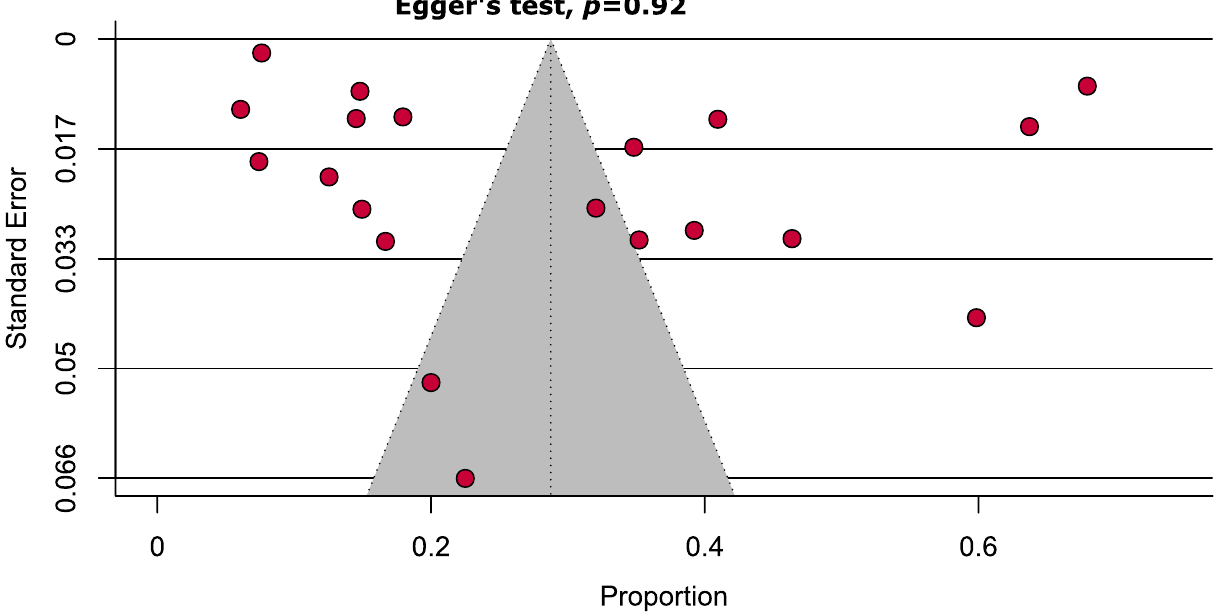
Figure 3. Funnel plot representing the prevalence of metabolic syndrome in Pakistan shows absence of significant publication